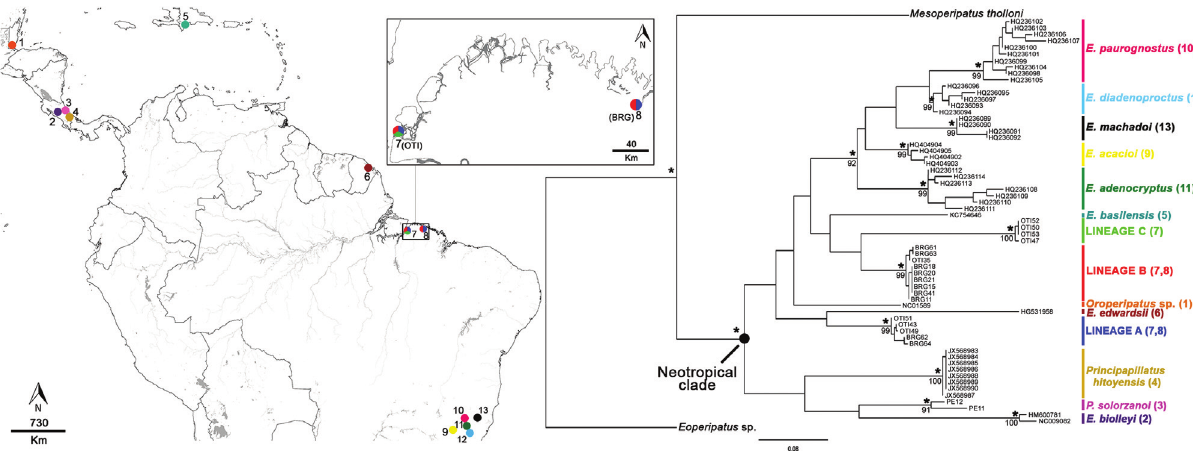
Figure 1 - Map showing the geographic distribution of the species of Peripatidae and sites analyzed in the present study. Numbers correspond to locality records listed in Table S1 (Supplementary material). Colours refer to the clades based on the phylogenetic tree. Topology obtained from the ML analyses of mitochondrial COI. Above: asterisks indicated Bayesian posteriors probabilities > 0.9; below: numbers nodes are bootstrap values > 75%. Abbrevia- tions: OTI = Outeiro Island; BRG = municipality of